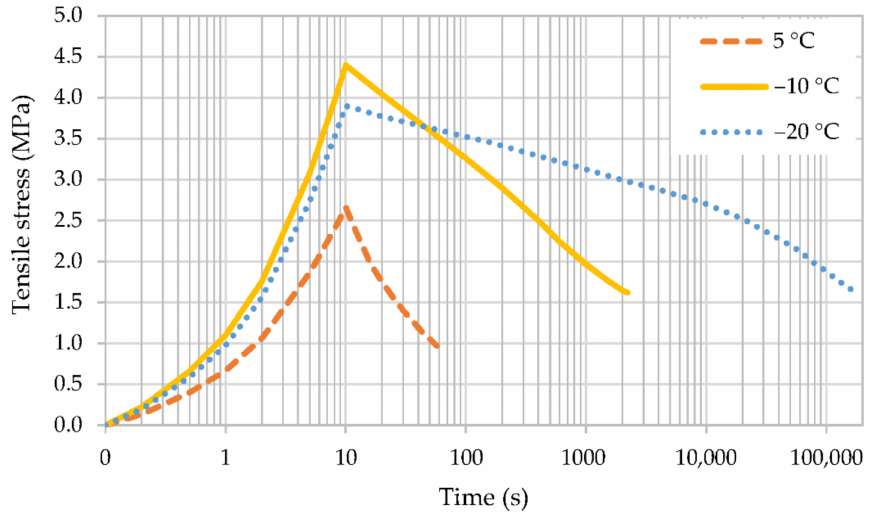
Figure 10. Evolution of the tensile stress over time for the PMB25 mixture in the relaxation test at different